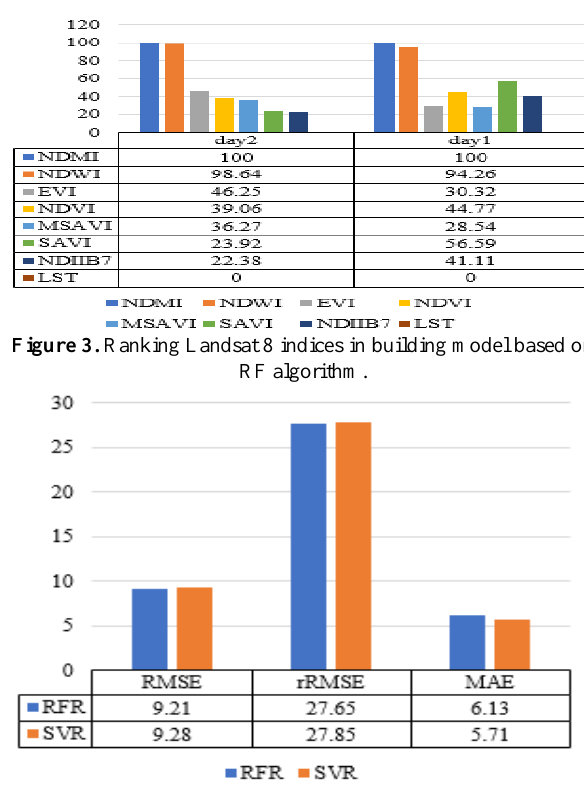
Figure 4. ML models performance on the first